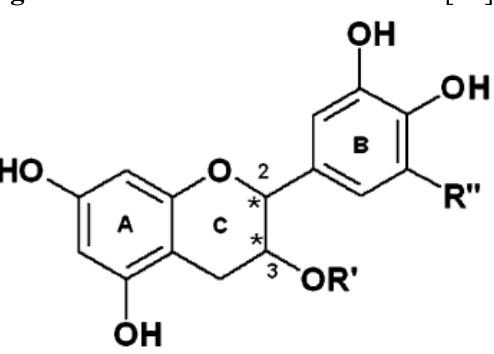
Figure 1. Basic structure of flavonols [34].